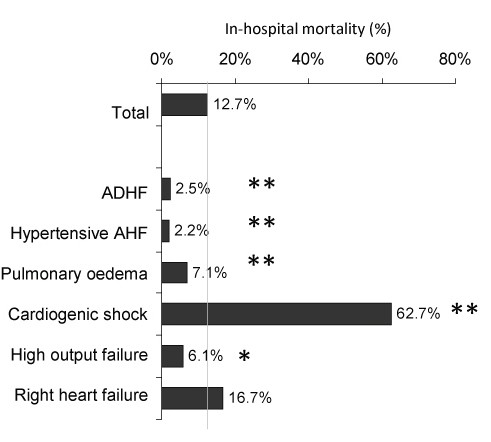
In-hospital mortality according to syndromes of acute heart failure. Statistical significance denoted as ** <0.001; *<0.050. ADHF - Acute decompensated heart failure, AHF - Acute heart failure.